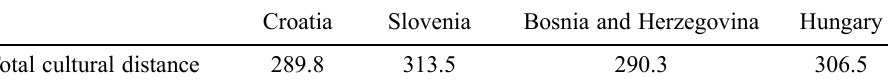
Table 7. Total cultural distance, calculation for Croatia,